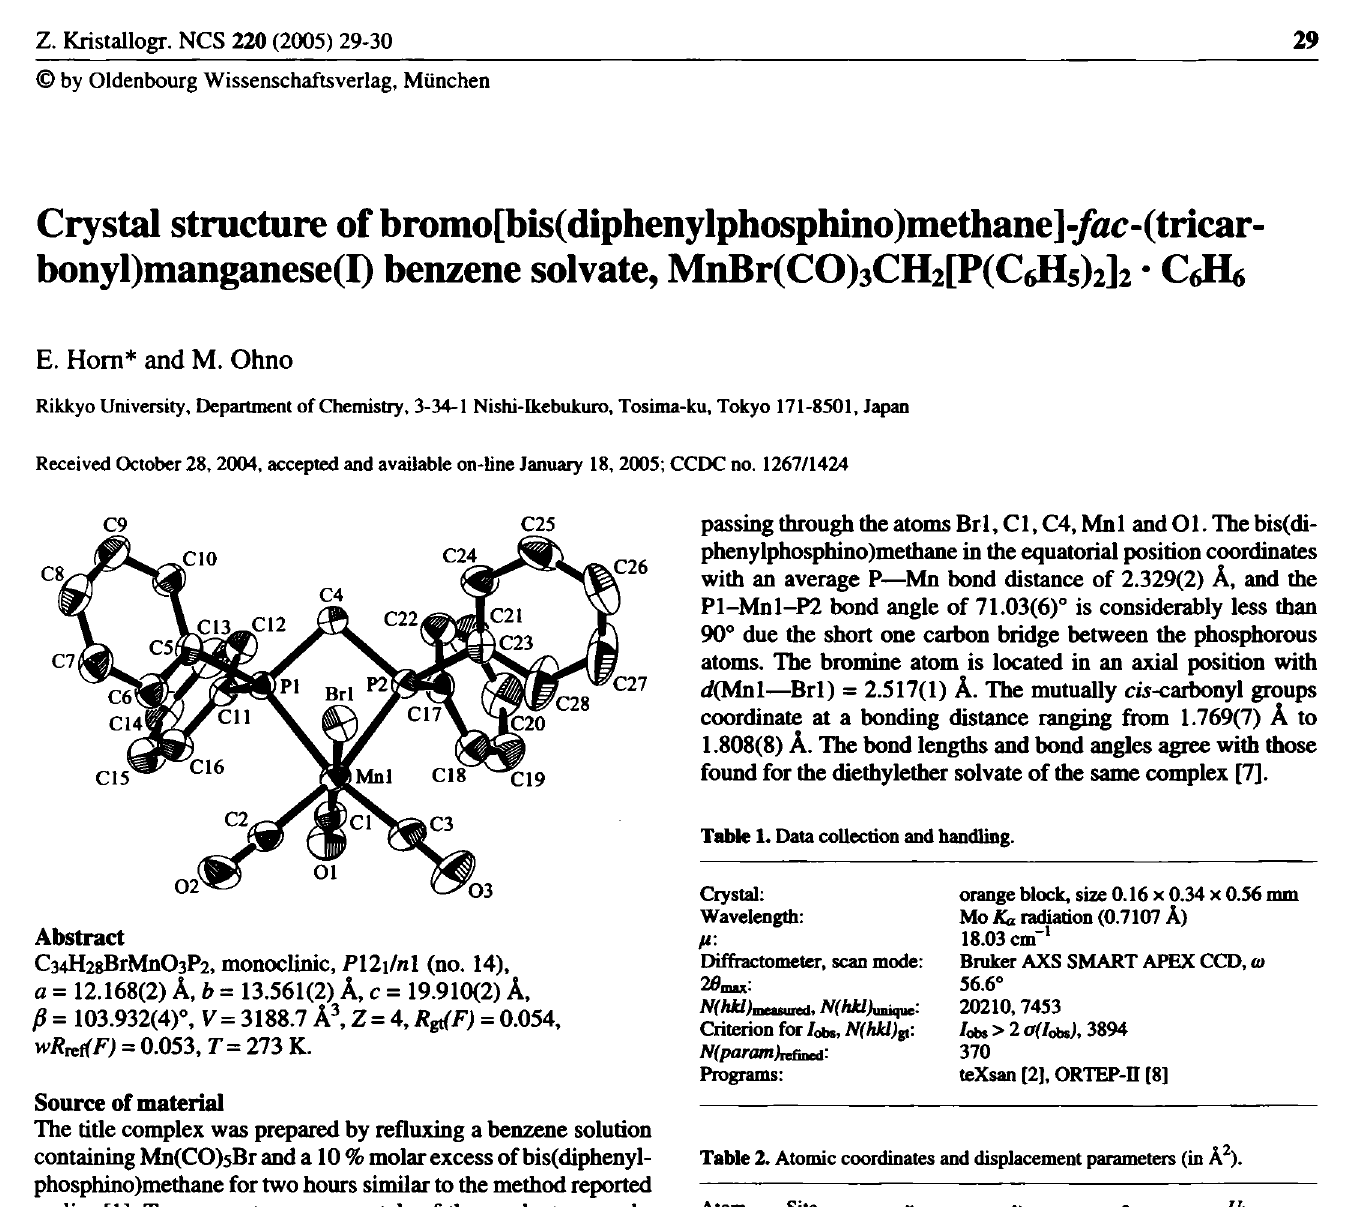
Table 2. Atomic coordinates and displacement parameters (in Ä 2